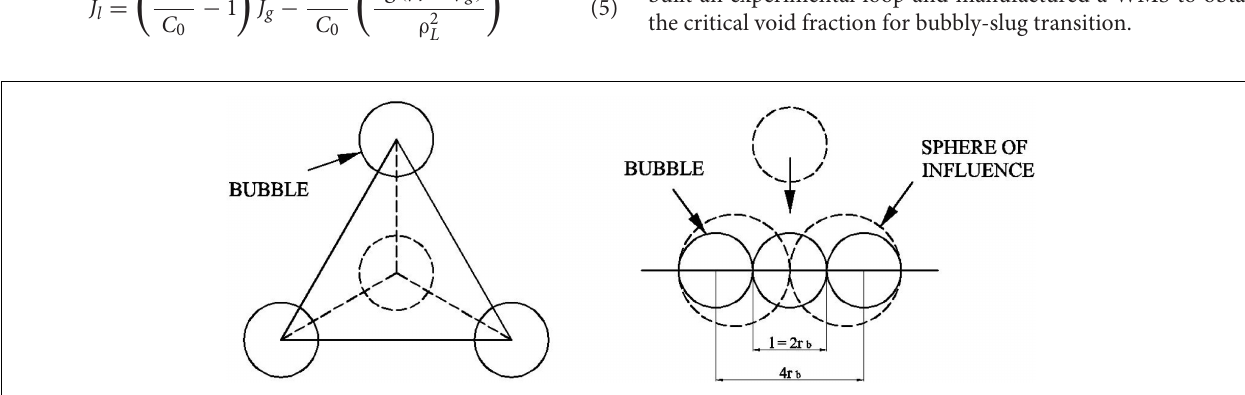
FIGURE 1 | Bubble packing and coalescence